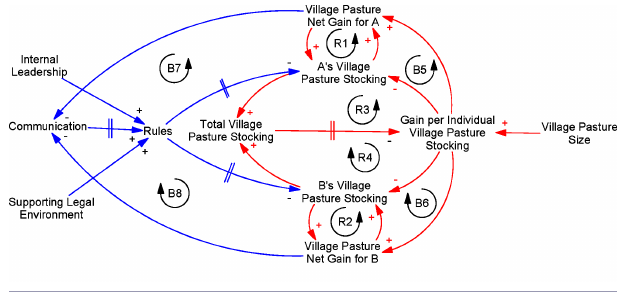
Fig. 3 . The Tragedy of the Commons archetype leading potentially to unsustainable common village pasture management (red) and solution by communication and rule development (blue).